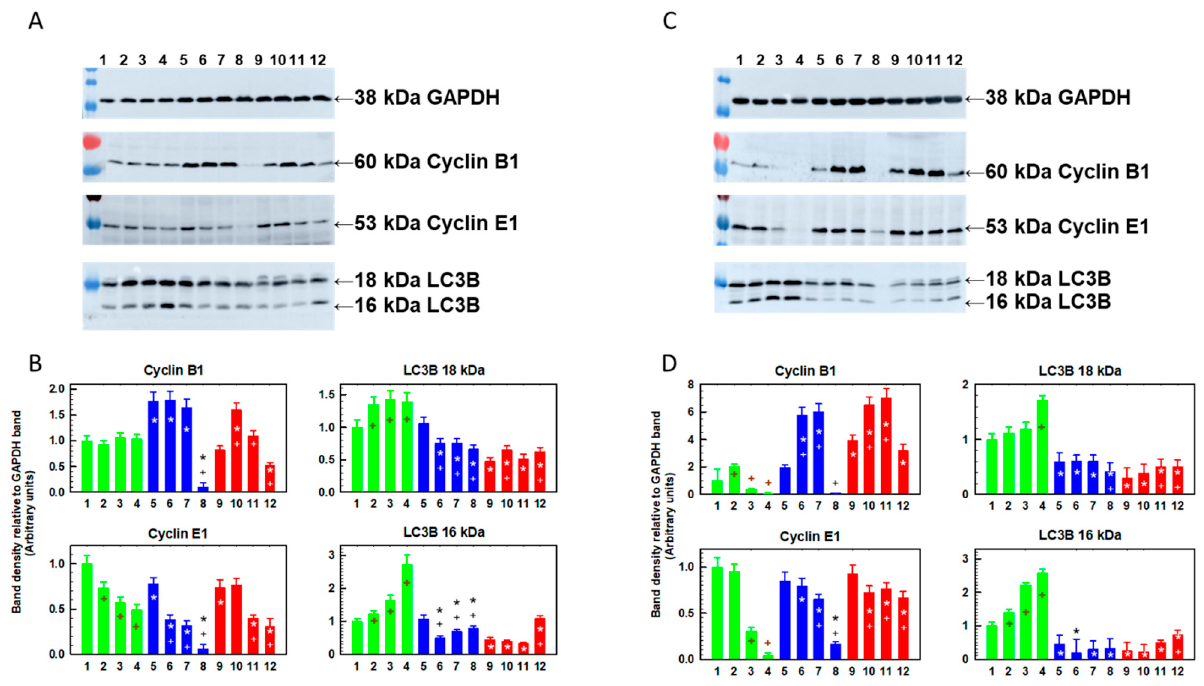
Figure 6. Changes in the relative content of cyclin B, cyclin E and LC3B protein fragments (16 and 18 kDa) in S, R and T cells passaged either one or four times in SFN-containing medium. Panels A and B: The cells were cultured for 48 h in the presence or absence of SFN. Panels C and D: Cells were passaged four times for 48 h in the presence or absence of SFN. SFN concentrations: (1) 0 µ M S cells, (2) 5 µ M S cells, (3) 10 µ M S cells, (4) 15 µ M S cells, (5) 0 µ M R cells; (6) 5 µ M R cells, (7) 10 µ M R cells, (8) 15 µ M R cells, (9) 0 µ M T cells; (10) 5 µ M T cells, (11) 10 µ M T cells and (12) 15 µ M T cells. ( Panels A,C ) Western blot determination of the respective proteins. Signals for GAPDH were used as internal controls. Data are representative of three independent measurements. ( Panels B,D ) The optical densities of the protein bands were quantified and are summarized in bar plots. The data are expressed as the mean ± SD of three independent measurements. S cells (green), R cells (blue) and T cells (red). Significance * means that the data differ from corresponding conditions observed for S cells at the level p < 0.02; + means that data differ from corresponding obtained for cells in the absence of SFN p <